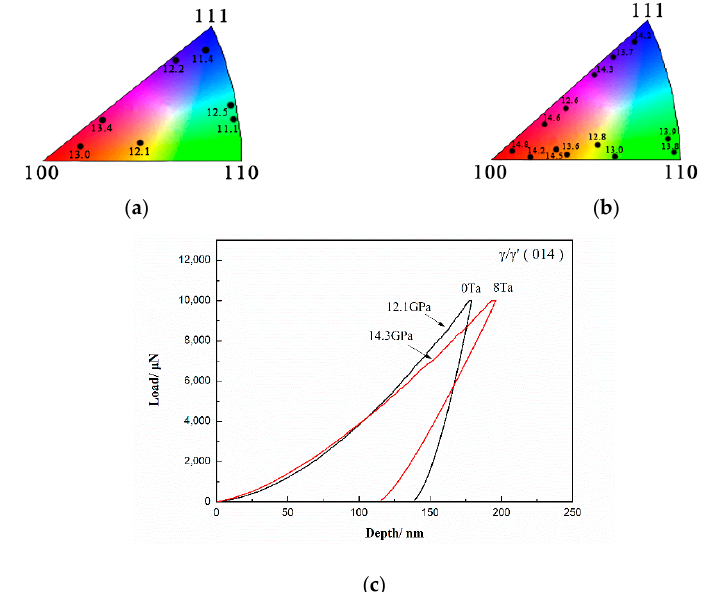
Figure 7. Nanohardness of different orientations in Ir-based alloys: ( a ) Ir–6Al–13W alloy; ( b ) Ir–6Al– 13W–8Ta alloy; ( c ) Load–depth curves of γ / γ′ (014) orientation. Ir–6Al–13W–8Ta alloy; ( c ) Load–depth curves of γ / γ (cid:48) (014)